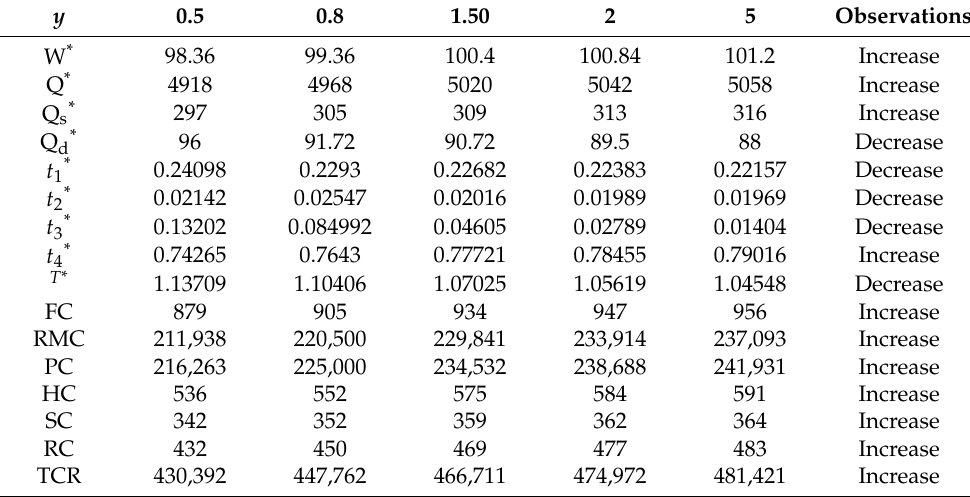
Table 3. Sensitivity of “ y ” to different decision variables and costs. The static input values of the